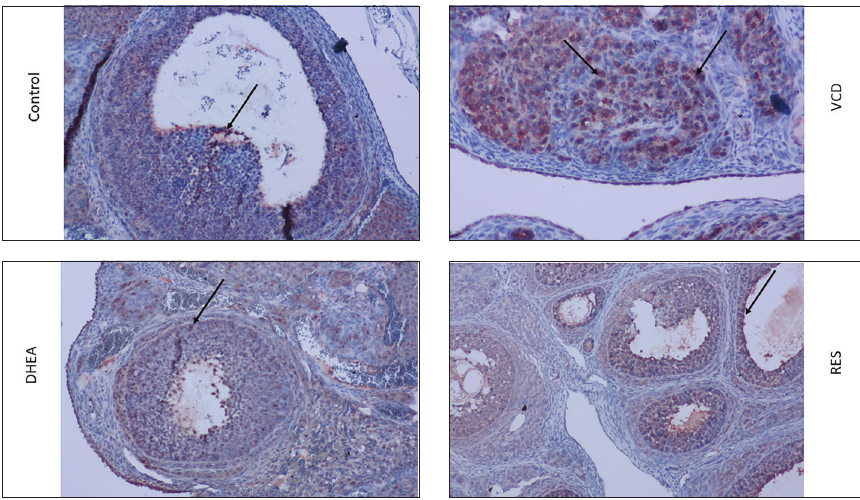
Figure 2. Histologic sections showing ovarian follicle and apoptotic cells of Control, VCD, DHEA, and RES. In the study groups, some of the tunnel-positive stained cells were shown with arrows to indicate apoptosis.